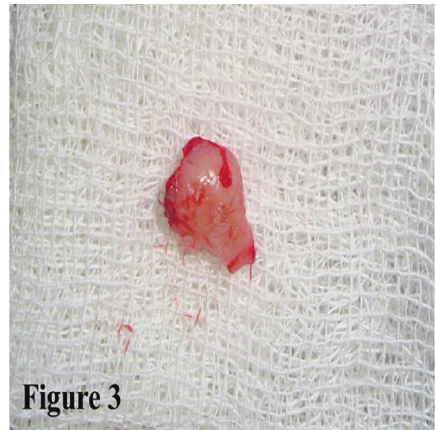
Figure 3: Gross specimen.